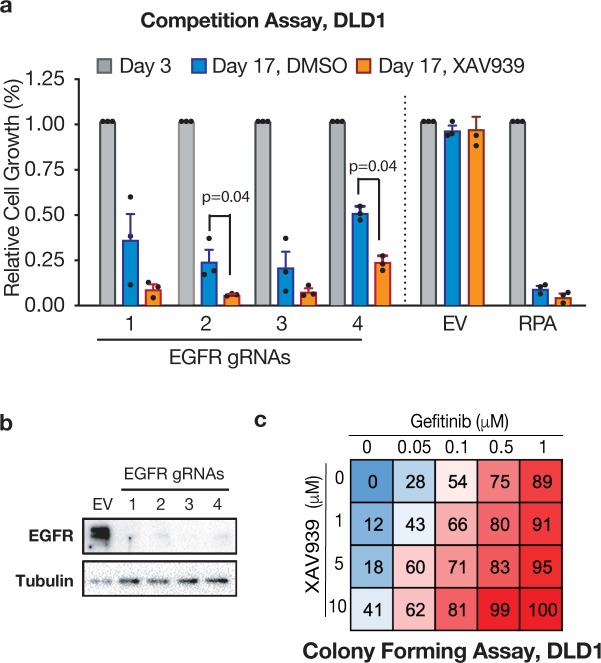
Synergistic EGFR and TNKS inhibition.a. Fluorescence-based competitive assay demonstrating enhanced inhibition of cell growth upon simultaneous TNKS inhibition and EGFR knock-out using four independent gRNAS. b. Western blot detection of EGFR in DLD1 cells treated with the indicated gRNAs. c. Cell growth inhibition in DLD1 cells treated with the indicated inhibitors for 15 days.